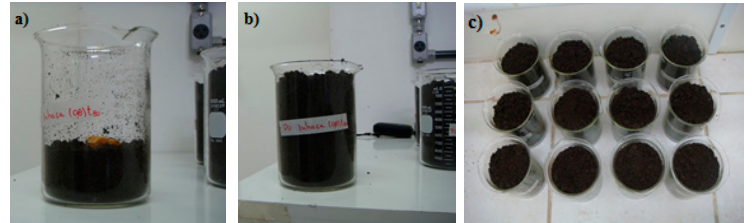
Figure 2 . ( a ) Samples placed in the soil, ( b ) flasks filled with prepared soil, and ( c ) sample incuba- tion. Samples buried in the soil (one in each beaker) were removed after 40, 80, and 120 days. The samples were carefully washed with distilled water and dried in a vacuum oven at 28 °C for 24